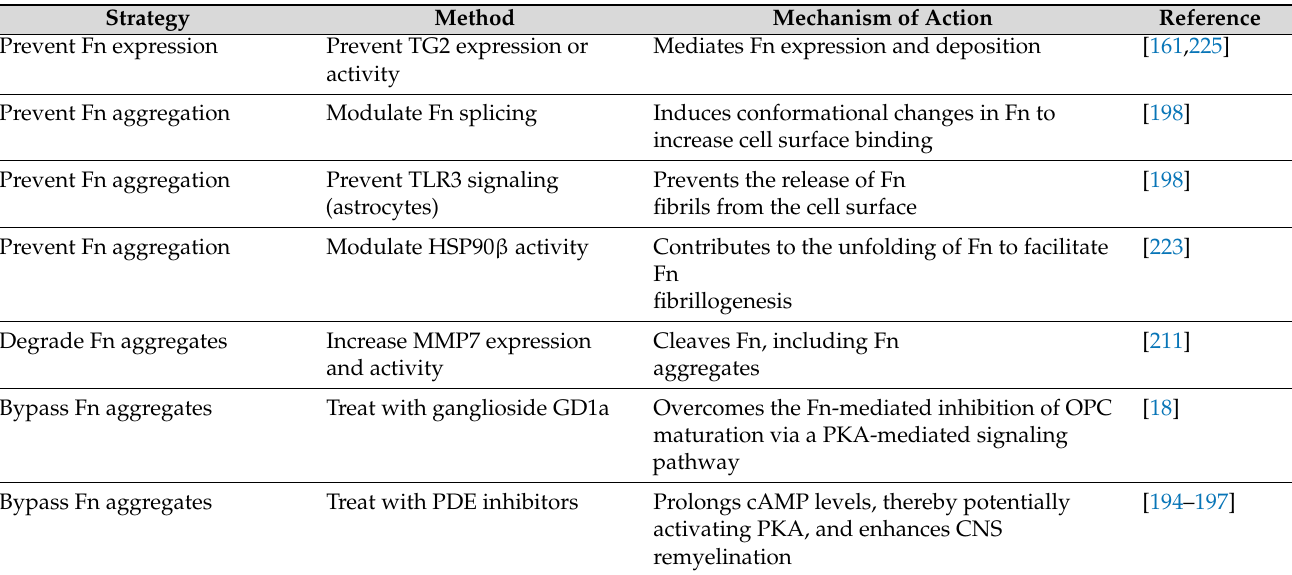
Table 1. Potential therapeutic strategies to overcome the fibronectin-aggregate-mediated inhibition of remyelination